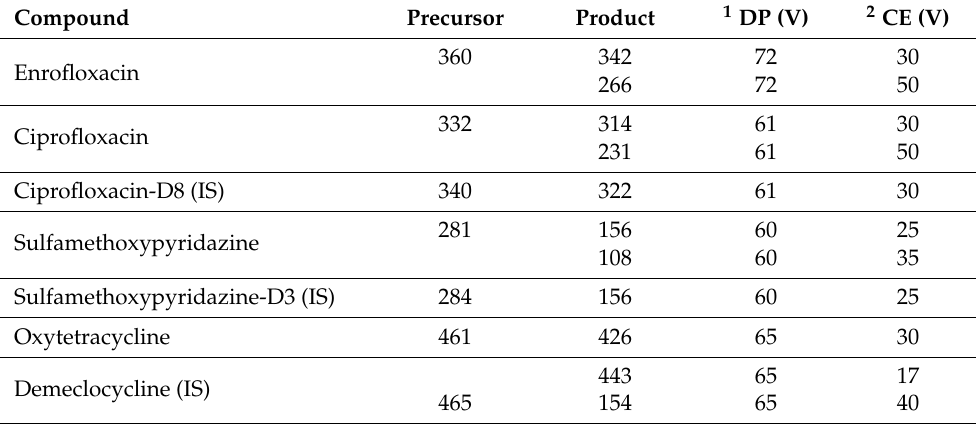
Table 3. Monitored ions via LC-MS/MS ESI+ in MRM